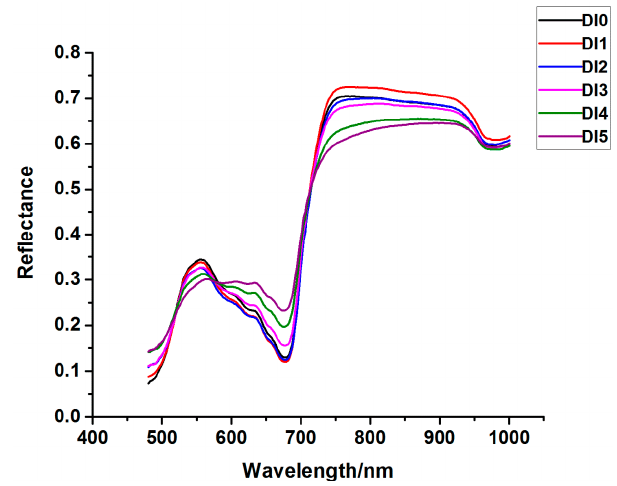
Figure 2. Average spectral curves of samples in six degrees of infestation.